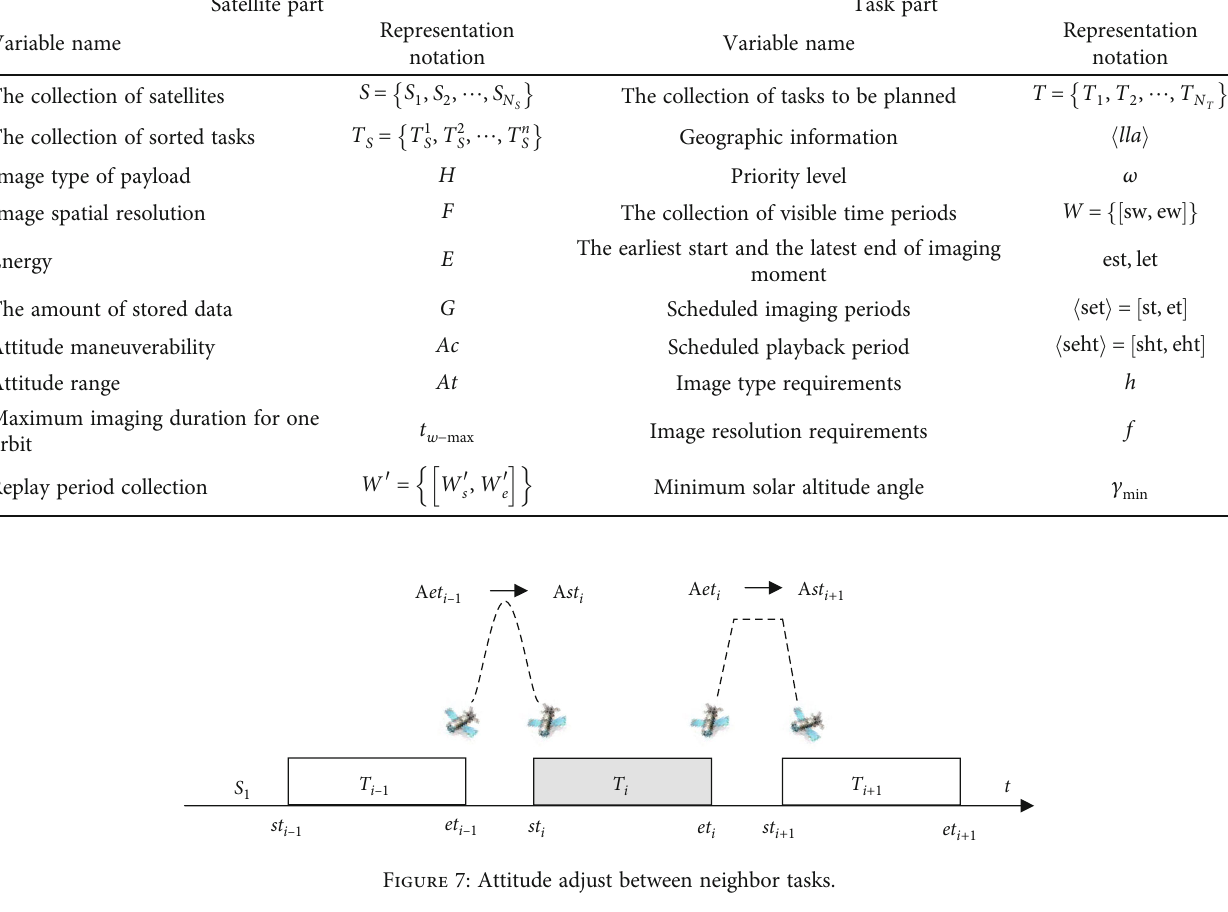
Figure 7: Attitude adjust between neighbor